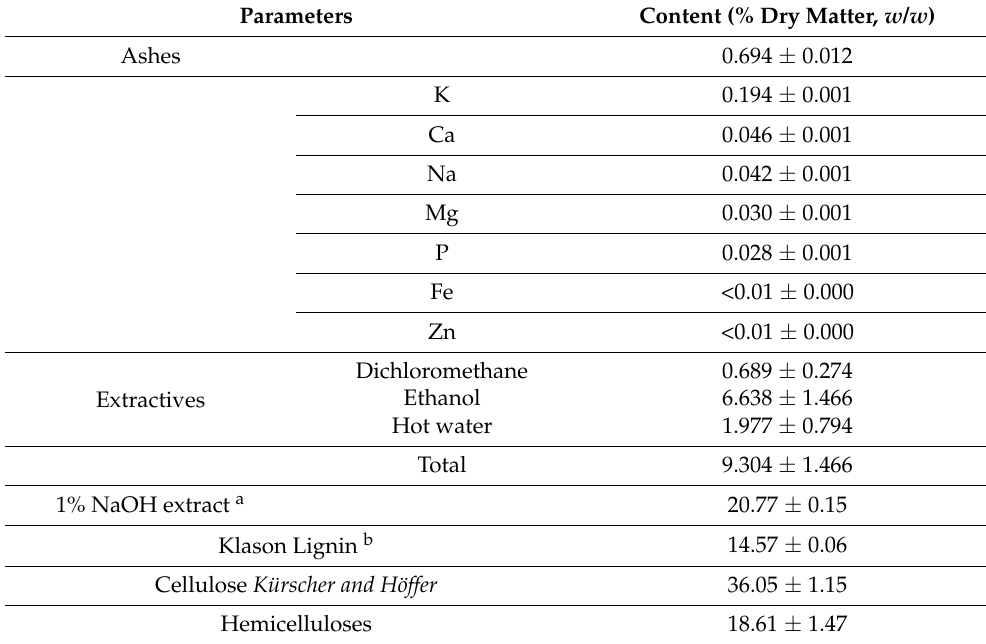
Table 1. Chemical composition of